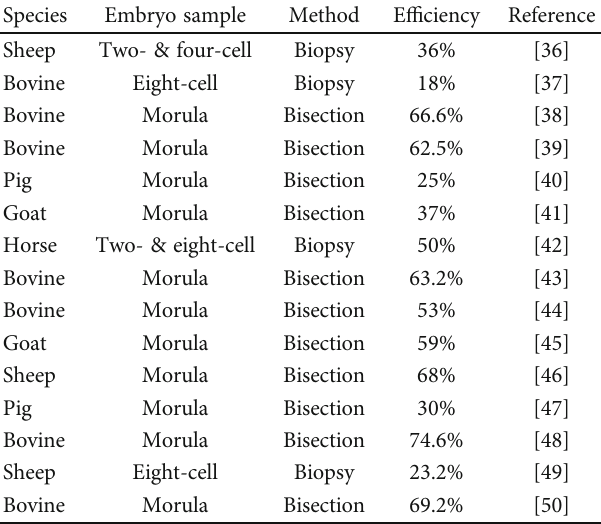
Table 2: Studies in livestock embryo splitting.